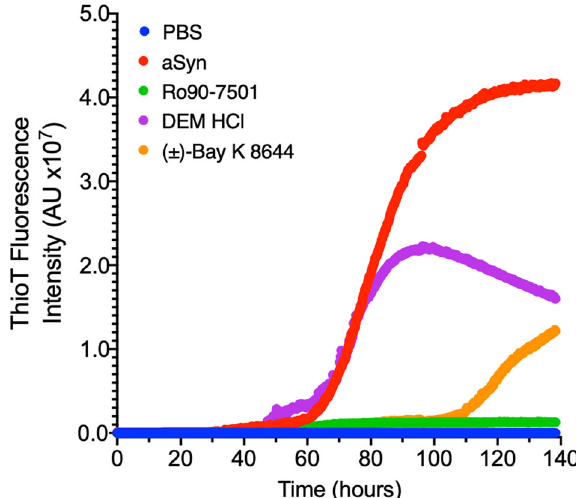
Fig. 10 Monomer induced aggregation of α SN (non-seeded Thio fl avin-T assay). Recombinant α SN was incubated at 140 μ M monomer (70 μ M compound) under continuous shaking (900 RPM) at 37 °C. All three hit compounds modulated α SN fi brillization with RO having a more signi fi cant effect over Bay and DEM, respectively.